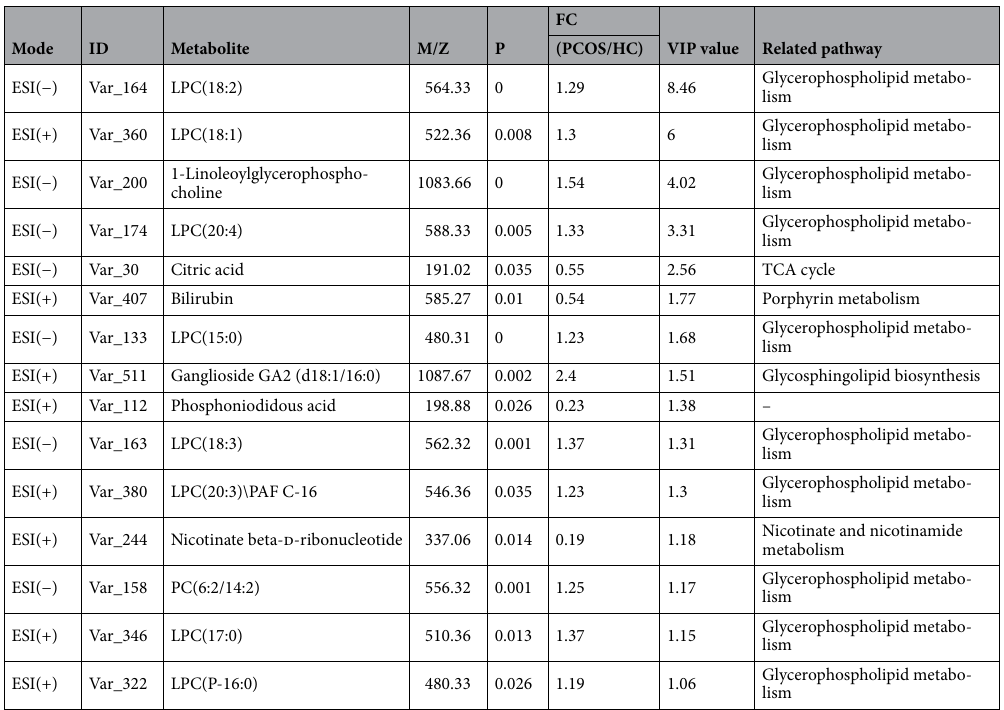
Table 2. Identified serum metabolites and related metabolic pathways between PCOS and control. M/Z, mass-to-charge ratio; ESI(−), negative ion scanning mode; ESI(+), positive ion scanning mode; VIP, variable important in projection; FC, fold